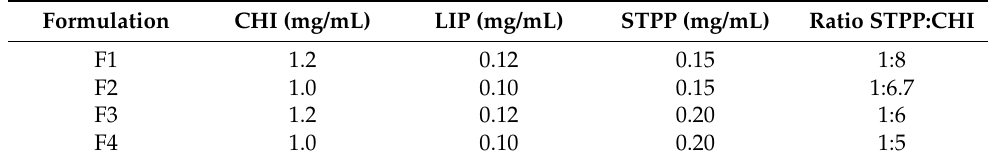
Table 1. Formulations of surfactant-polyelectrolyte